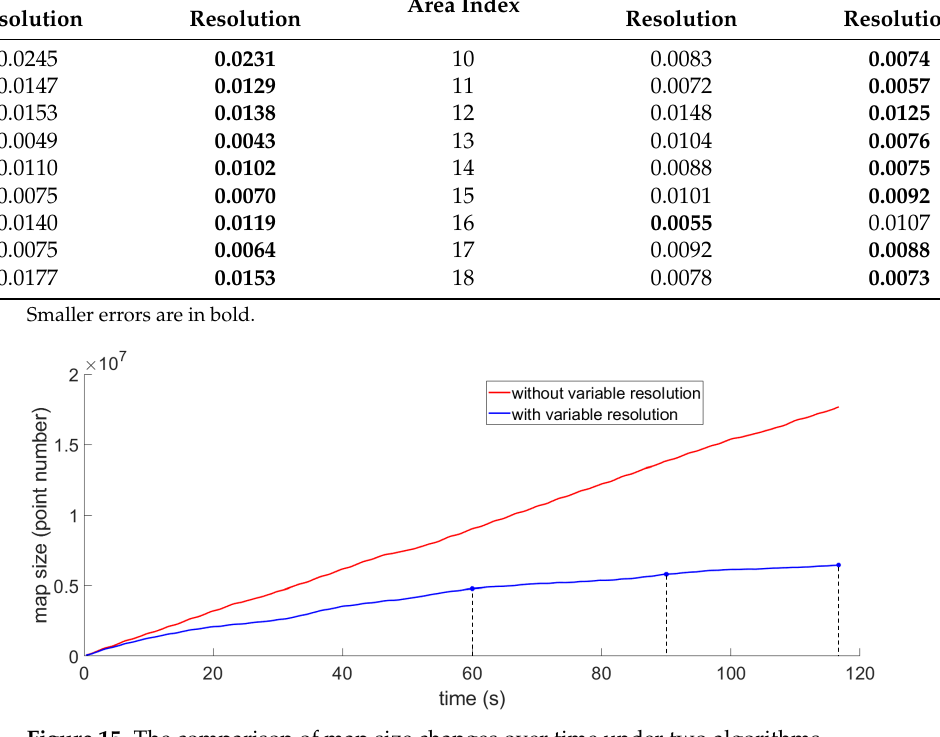
Figure 15. The comparison of map size changes over time under two